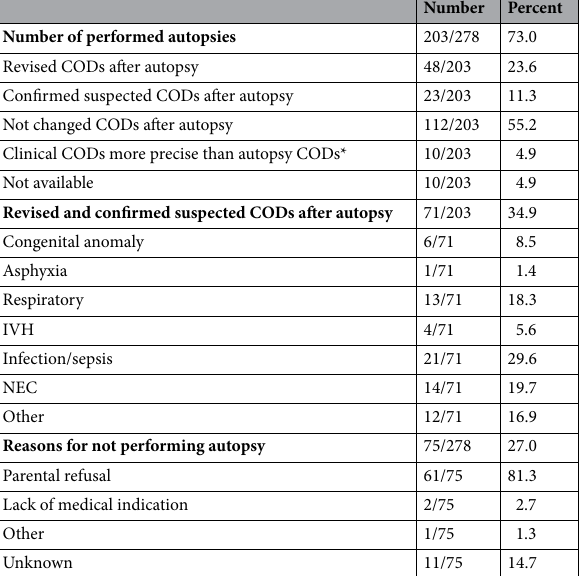
Table 2. Number of performed autopsies, diagnosis after autopsy of revised and confirmed suspected causes of death (CODs), and reasons for not performing autopsy (2002–2018). *If the autopsy defined the COD as “prematurity”, the clinical diagnosis was used as a definitive COD. In 3 of these 10 cases, the clinical COD was also